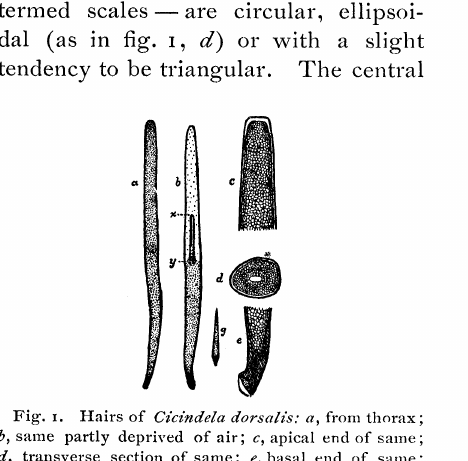
Fig. Hairs of Cdcddela dorsalfs: a from thorax; partly deprived of air; c, apical end of same; transverse section of same; e basal end of same; gr, hair from antenna. F_.nlargement: a, and gr, dam. c, d and e, 3o0 diam. portion is a canal, about one-fourth the diameter of the whole hair, and is filled with air.